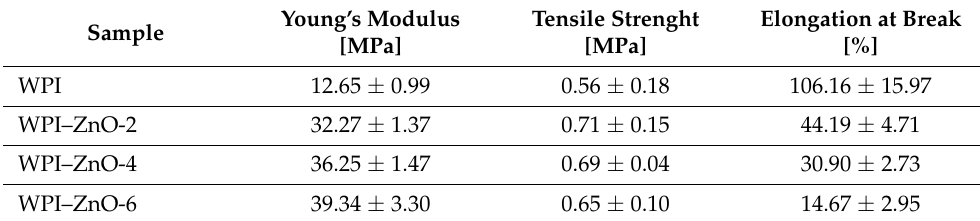
Table 1. Mechanical properties of WPI and WPI–ZnO